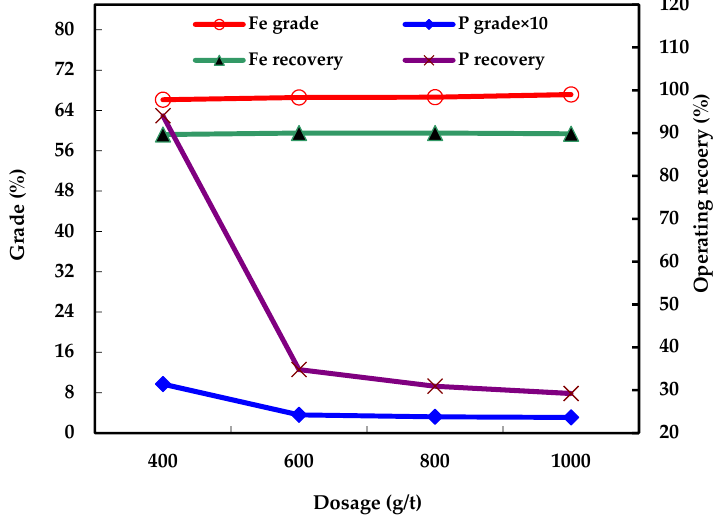
Figure 5. Effect of toluenesulfonamide dosage on iron and phosphorus grades and recoveries in reverse flotation.